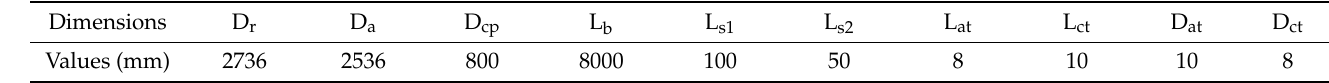
Figure 3. Schematic of a radial flow reactor, where Lb is the height of the reactor, Ls1 and Ls2 are the lengths of the top and bottom seal layer, Dr, Da and Dcp are the diameters of the reactor, outer bed and the center pipe, respectively, Lat and Lct are the thickness of the center pipe and annular flow distributor, respectively and Dat and Dct are the opening diameters of the distribution plate on annular channel and center pipe, respectively. Table 1. Dimension parameters of the reactor.